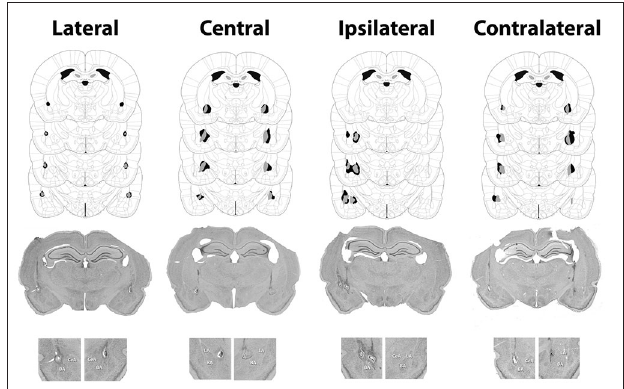
FIGURE 4 | Minimum (gray) and maximum (black) accepted lesions for subjects with bilateral LA or CeA lesions as well as ipsilateral or contralateral LA-CeA lesions . Figures were adapted from Paxinos and Watson (2013) and profile damage 1.72, 2.16, 2.64 and 3.12 mm posterior to bregma. Representative images for each surgical condition are presented below the schematics with an enlargement of the amygdala region from each image presented